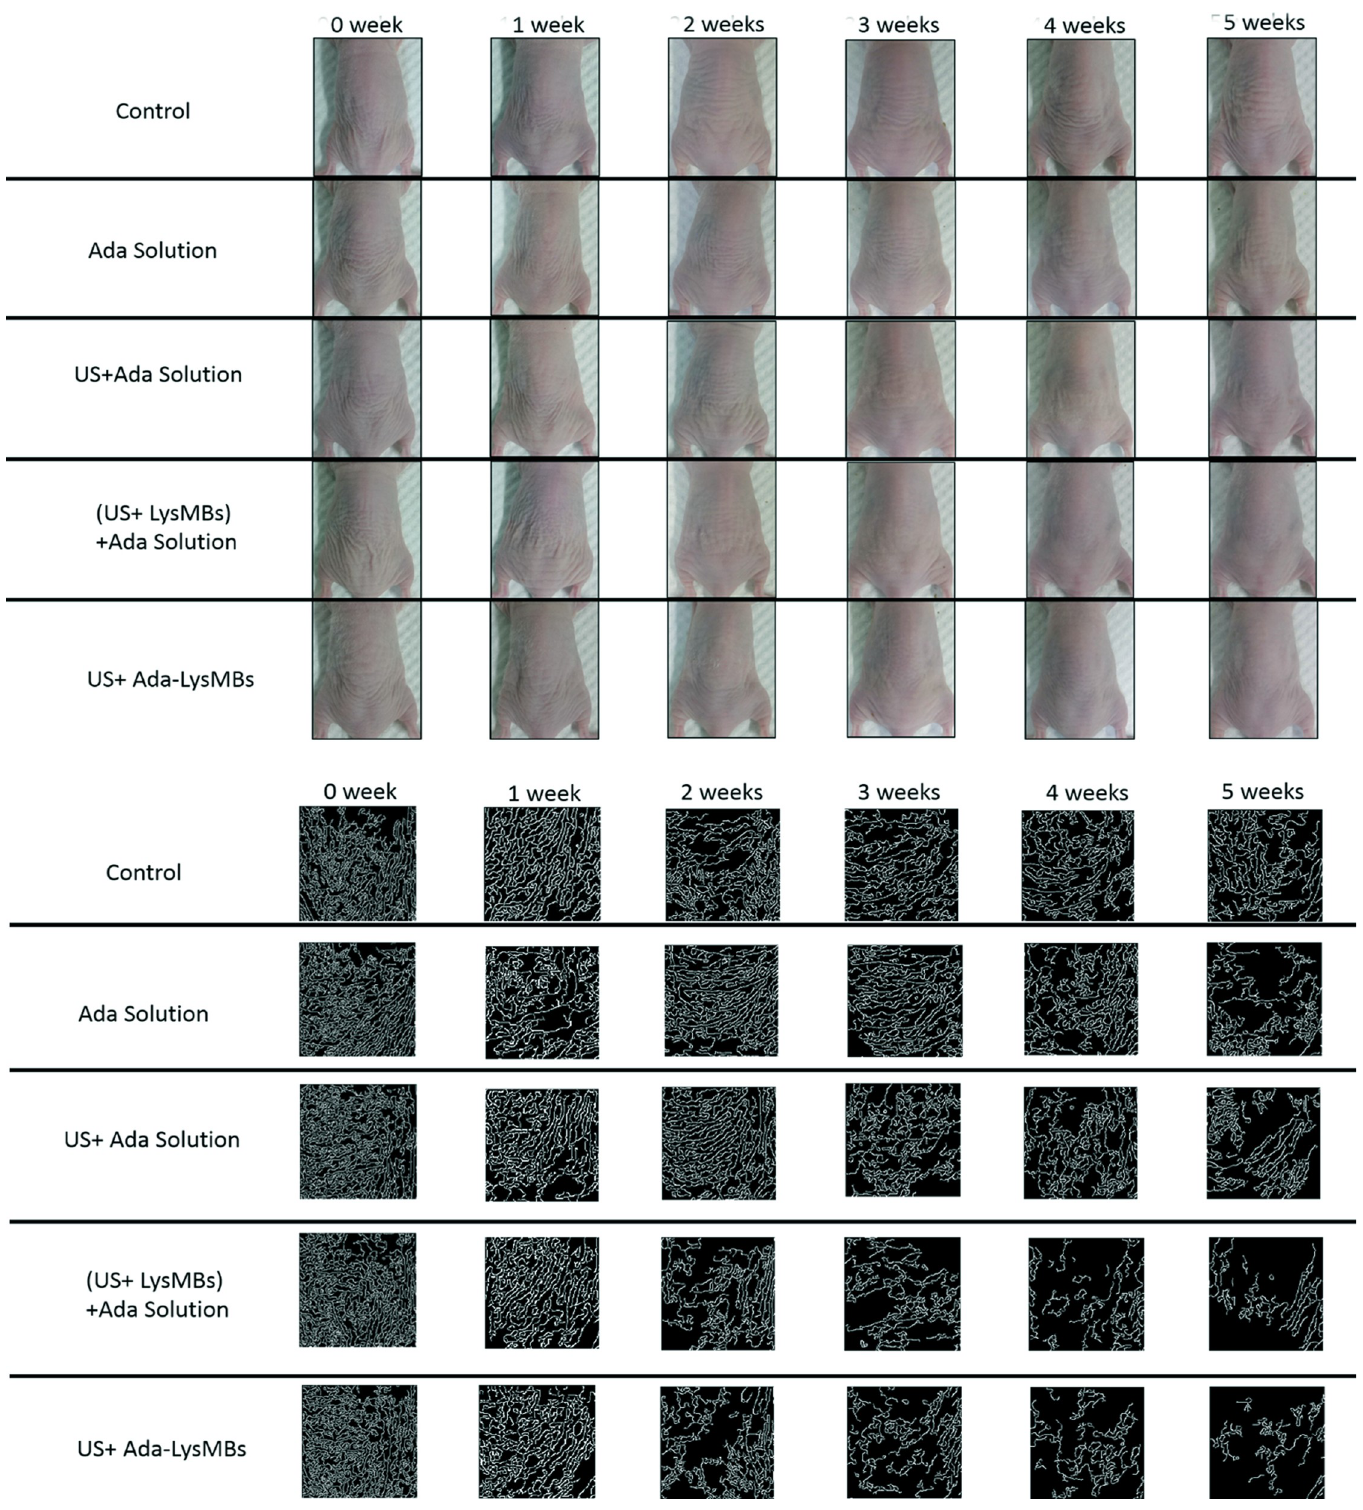
Fig 8. Photographs (A) and Canny wrinkle detection (B) of mice treated as indicated are shown at various time points during the treatment.